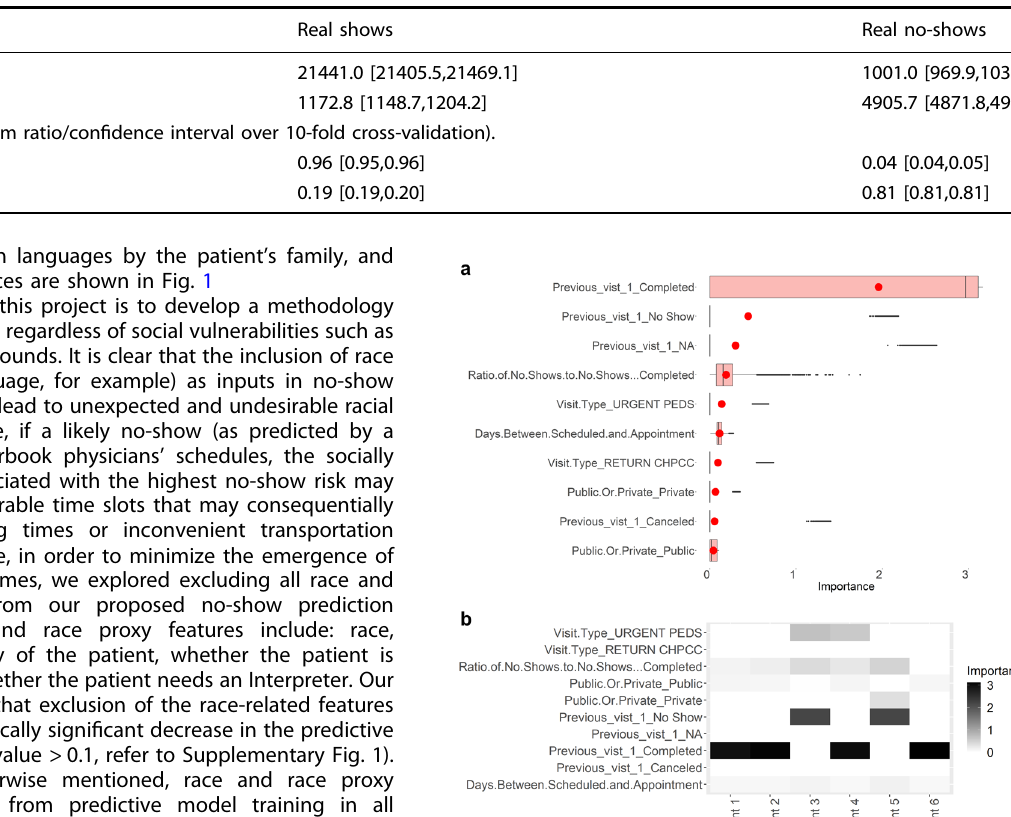
Table 2. Confusion matrix of neural network model trained and tested on only appointment records without missing information (mean and 90% con fi dence interval over 10-fold cross-validation are shown).